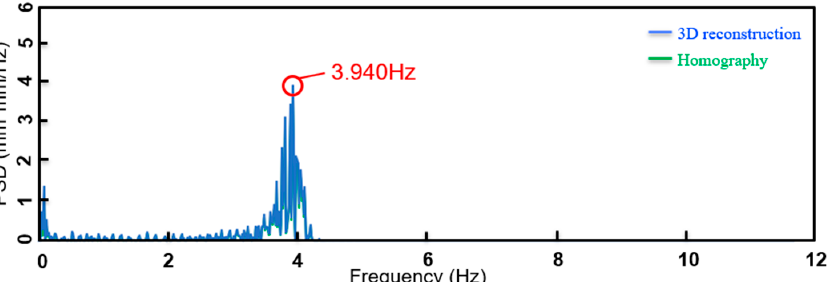
Figure 13. Comparison of PSD from 3D reconstruction and homography methods ( Z w = 0).